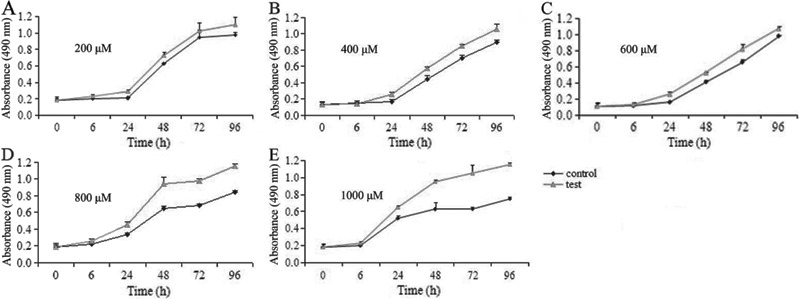
Cellular viability assay results of the control and test cells. The
capacity for cellular viability was examined using the MTT assay and cellular
viability was compared between the control and test cells (n=8).
A-C, The cellular viability of the test
cells was significantly greater than that of the control cells (P<0.05)
exposed to Cu-His at 200, 400, and 600
μM;D,E, the differences were significant
(P<0.01) among cells exposed to Cu-His at 800 and 1000 μM. The
t-test was used for statistical analysis.